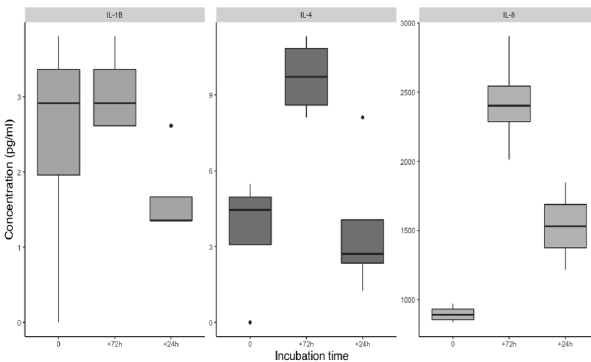
Figure 5. Incubation for 72 h - clarithromycin impact on pro- inflamma- tory mediators’ secretion. Figure shows the impact of clarithromycin, respectively, on IL-1β, IL-4 and IL-8 release by A459 cells. Before (incuba- tion time 0), after co-incubation (incubation time +72h), and 24 h after wash-out (incubation time +24h), cell culture supernatants were ana- lysed for the presence of the indicated cytokines by Luminex®. Values are expressed as mean ± SEM from 4 independent